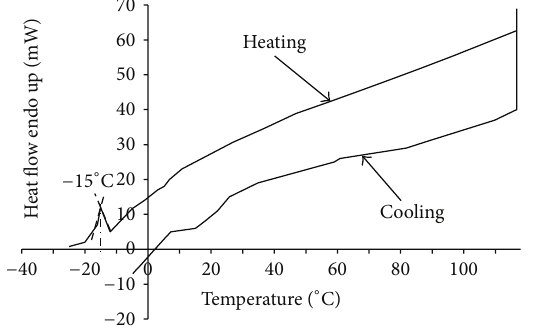
Figure 4: DSC curve for melting point determination of MSIMHSO 4 .